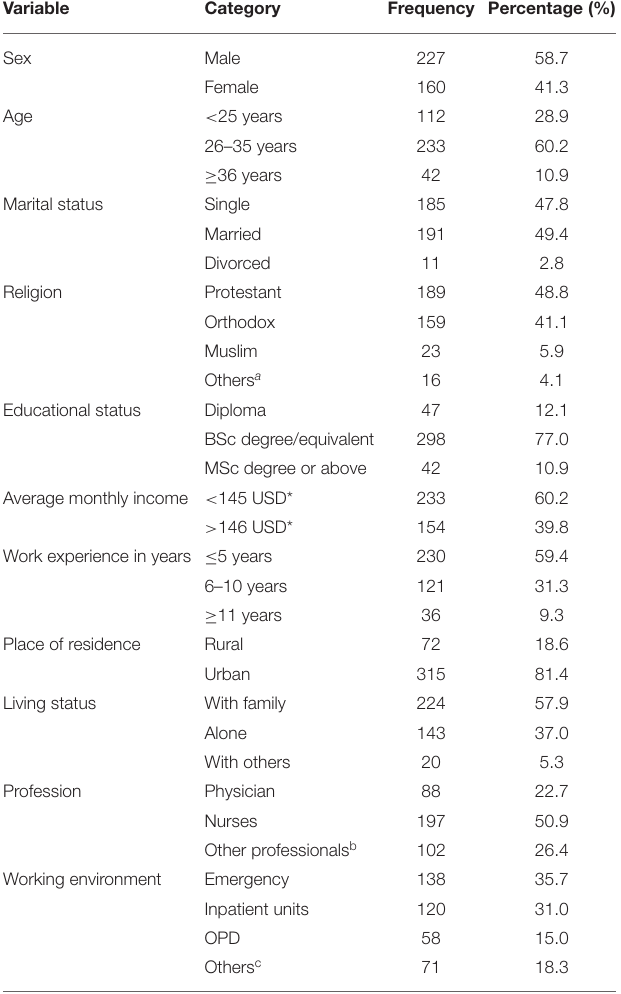
TABLE 1 | Socio-demographic characteristics of the study participants during COVID-19 pandemic in selected hospitals of Sidama National Regional State, southern Ethiopia 2020 ( n = 387).